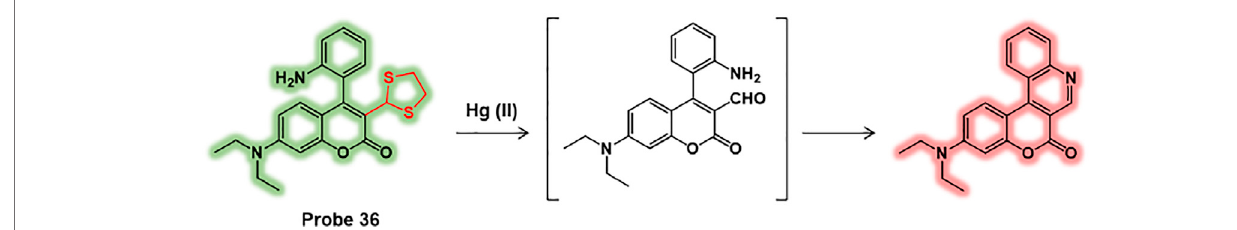
FIGURE 18 | Chemical structure of probe 36 and Hg (II) sensing mechanism.